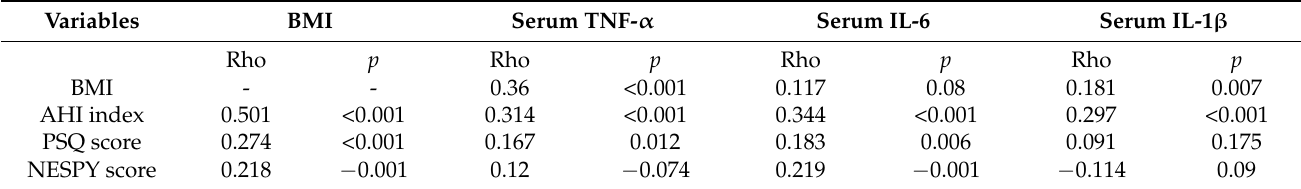
Table 4. Spearman’s correlation between baseline values of the diagnostic variables of OSAS severity and baseline BMI and serum levels of the studied cytokines.